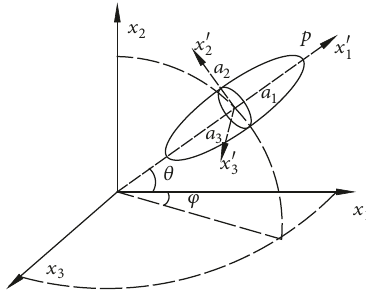
Figure 1: Orientation vector 𝑝 of a spatially oriented short fiber.